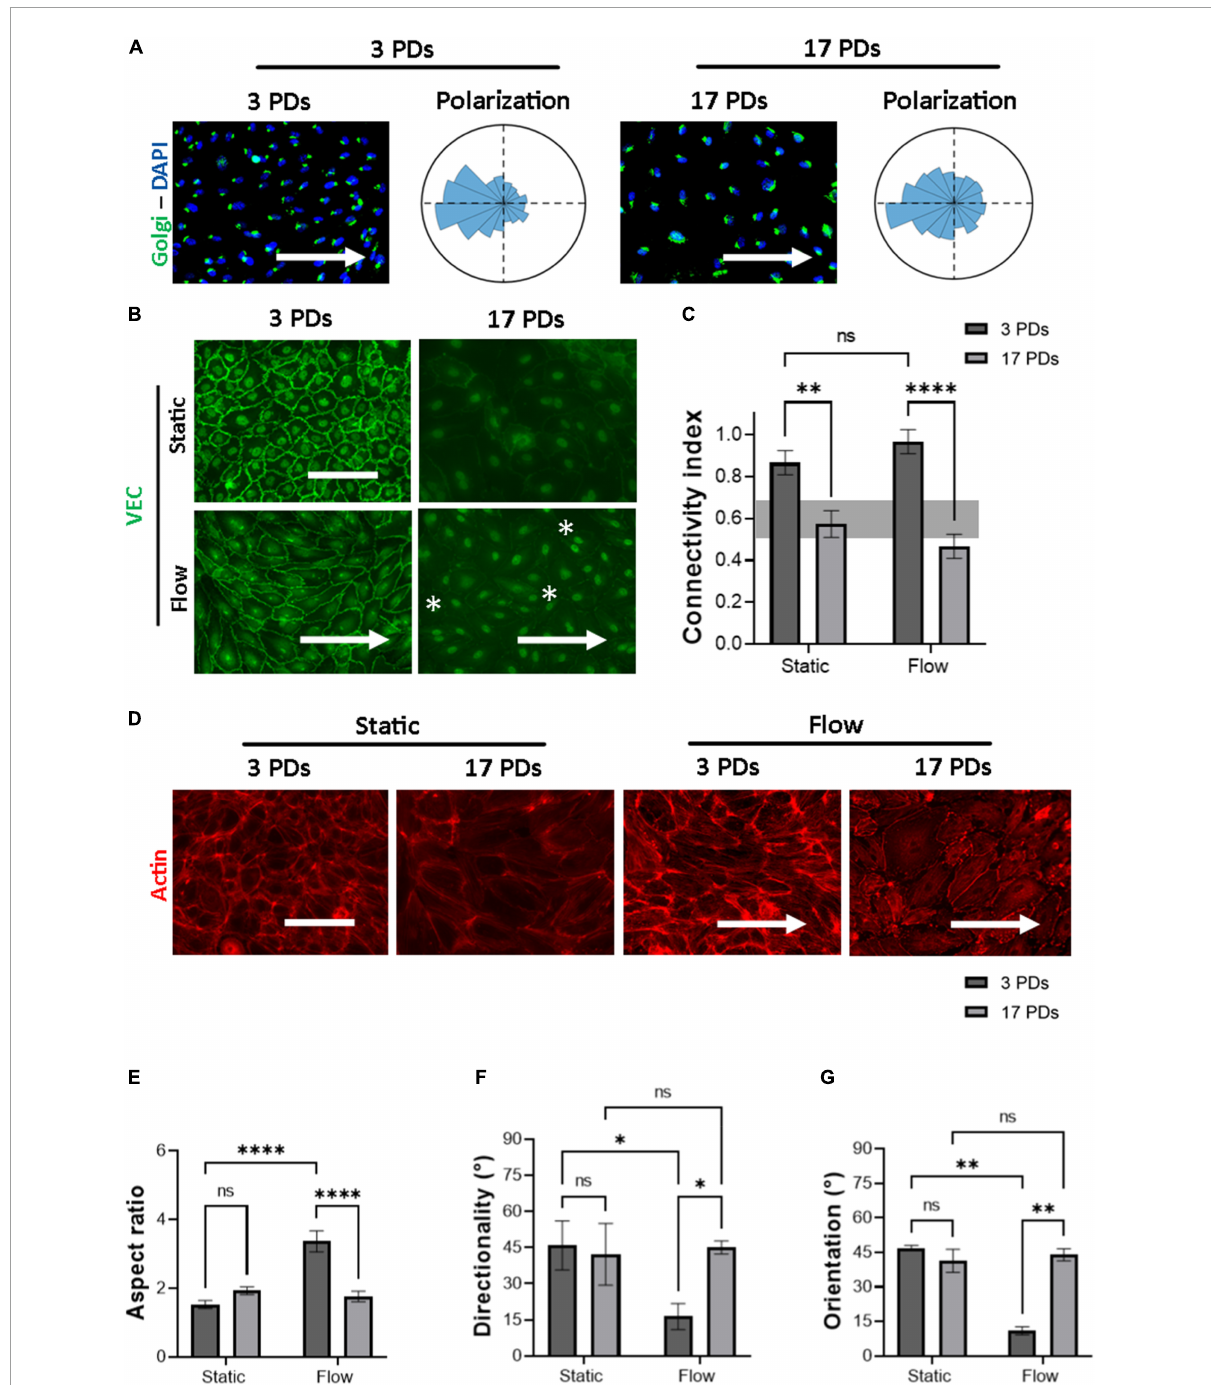
FIGURE2 Highly passaged HUVECs lose their monolayer integrity under physiological flow of 1.4 Pa. Representative immunofluorescence microscopy images for analysis of HUVECs cultured under flow conditions generating a WSS value of 1.4 Pa for 16 h; (A) cells stained with an antibody against the Golgi apparatus (green), the nuclei were stained with DAPI (blue). Histograms indicate the assessment of cell polarity. (B) Cells stained with an antibody against VEC (green), white asterisks indicate signs of monolayer disruption. (C) Measure of normalized VEC-CI values in non-senescent (3 PDs) and senescent (17 PDs) HUVEC monolayers grown under static and flow conditions with a WSS value of 1.4 Pa. (D) Cells stained with an antibody against Phalloidin (red). In (A,B,D) arrows indicate the direction of flow. Scale bars, 100 µ m. (E) Aspect ratio of cells defined as the ratio of major- to minor-axis length. (F) Average directionality of actin filaments in degrees according to the direction of the flow. (G) Average cell orientation in degrees according to the direction of the flow. In (C,E–G) , data represent the mean and standard error of the mean of 3 donors with more than 100 cells per condition. ∗ p < 0.05; ∗∗ p ≤ 0.01; ∗∗∗∗ p ≤ 0.0001; ns, not